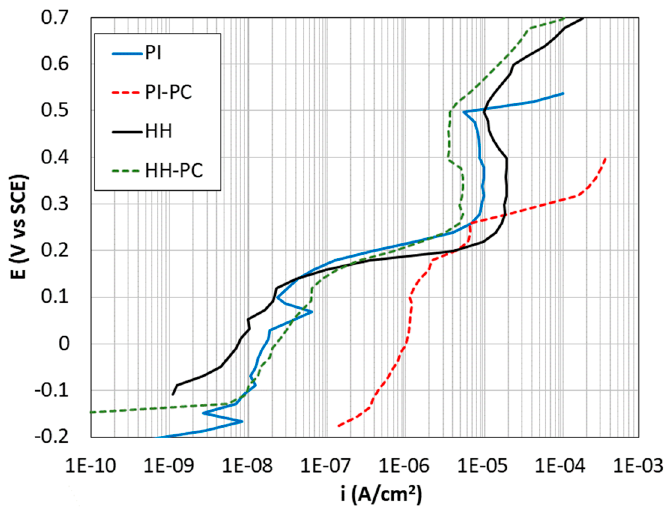
Figure 10. Anodic polarization curves obtained for S32001.